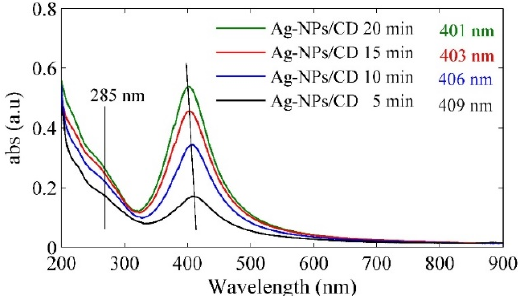
Figure 3. The UV–vis spectra of Ag–NPs/CD in a different ablation time.